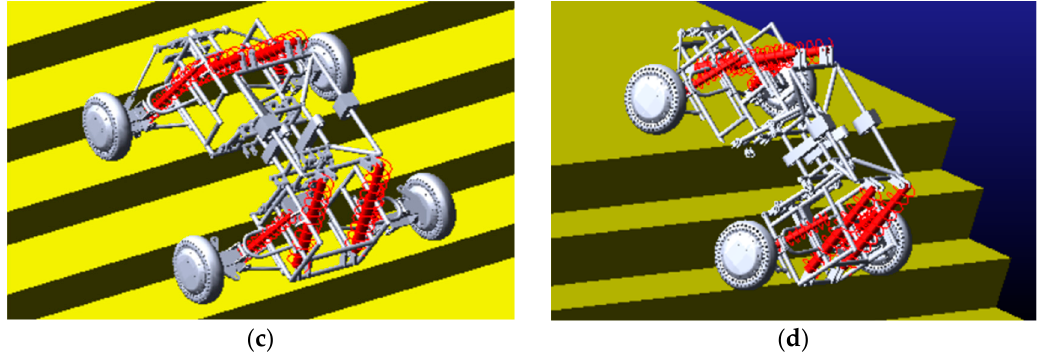
Figure 22. Experimental diagram in Experiment 3. ( a ) Experimental terrain, ( b ) Z-axis displacement of the center of mass of the front frame, ( c , d ) Simulation test process of car climbing stairs.